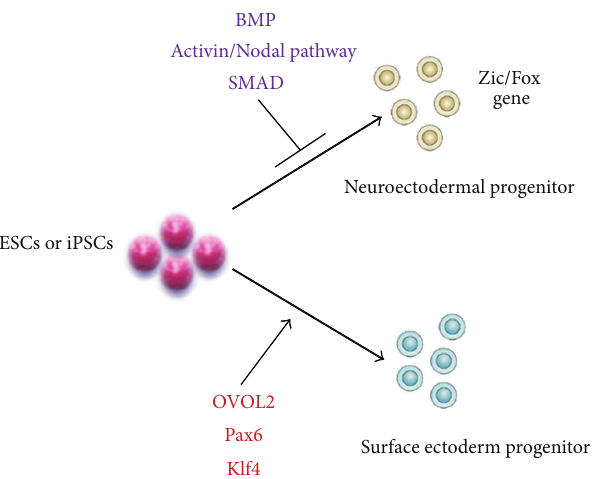
Figure 2: Schematic illustration of corneal epithelial cell differen- tiation from ESCs or iPSCs. Cultured human iPSCs treated with competitors of BMP, Activin, and Nodal pathways that result in the inhibition of Smad signaling become neuroectodermal progenitors due to activation of earlier neuronal genes (i.e., Zic and Fox family members). In contrast, OVOL2, repressed mesenchymal genes, together with PAX6 and Klf4, activate corneal epithelium differentiation. BMP, bone morphogenetic proteins; OVOL2, ovo- like zinc finger 2; Pax6, paired box protein Pax-6; Klf4, Kruppel-like factor 4; Zic, zinc finger; Fox,